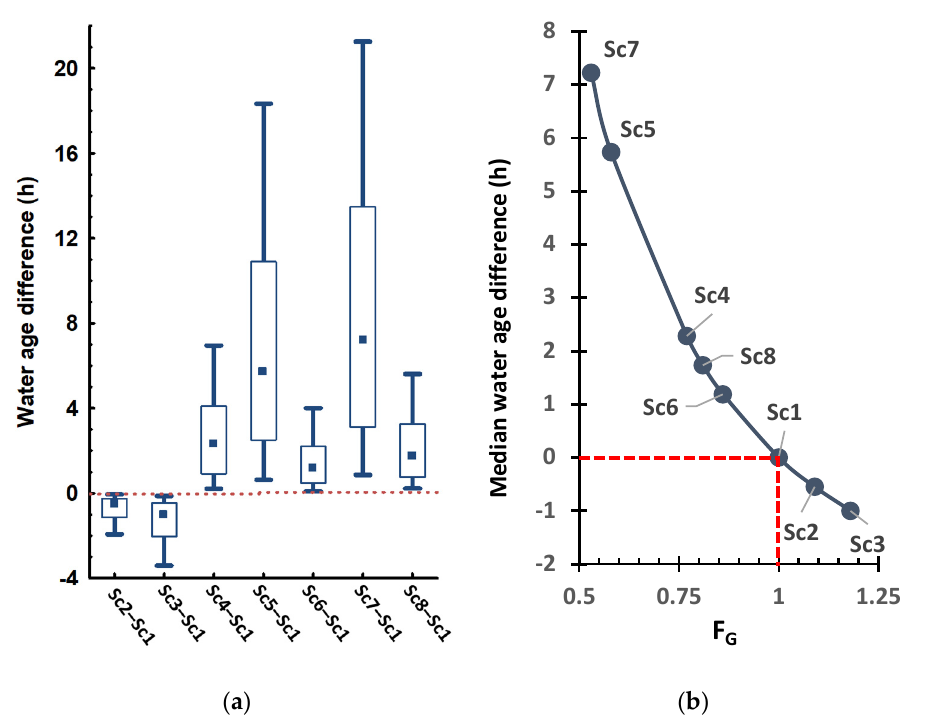
Figure 1. ( a ) Distribution of nodal differences in daily maximum water age from Sc2 to Sc8 and the current scenario (Sc1); Median; Box: 25–75%; Whisker: 10–90%; and ( b ) Median of maximum water age differences (from Figure 1a) versus the associated global multiplicative factor (F G ).